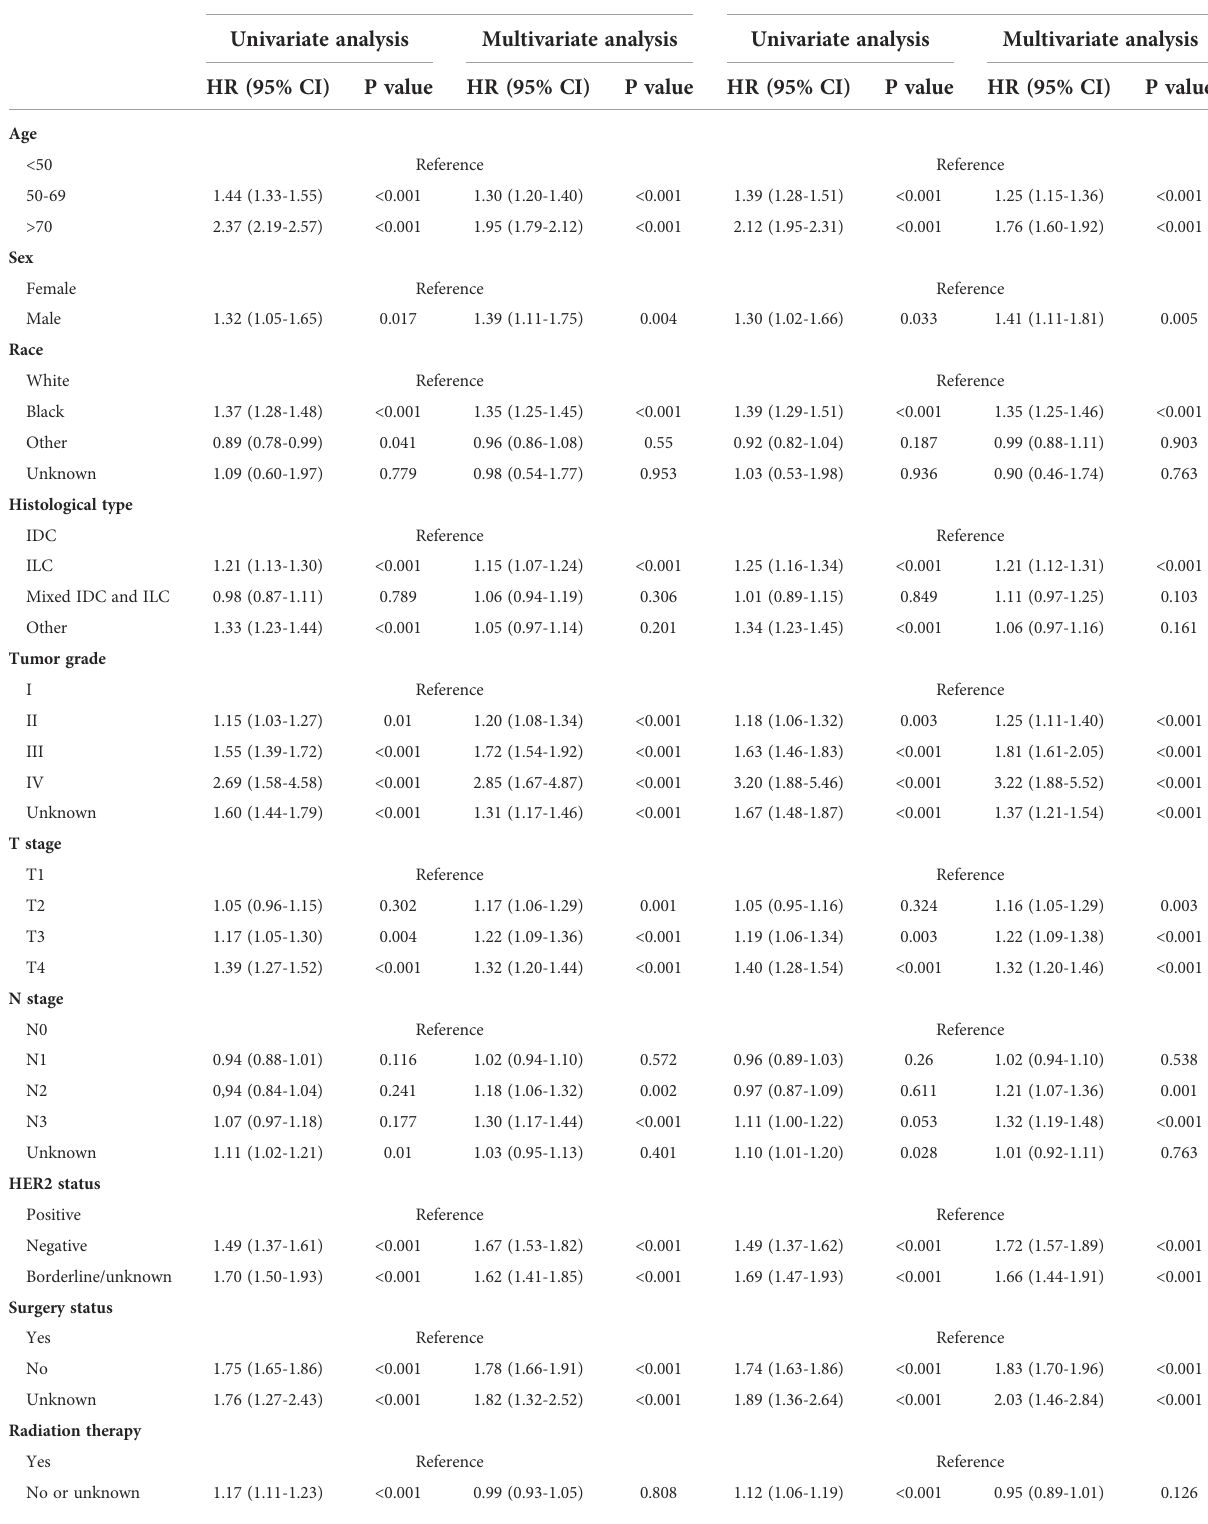
TABLE 3 Univariate and multivariate Cox proportional hazard regression of OS and BCSS in breast cancer patients with bone metastasis. OS BCSS Univariate analysis Multivariate analysis Univariate analysis Multivariate